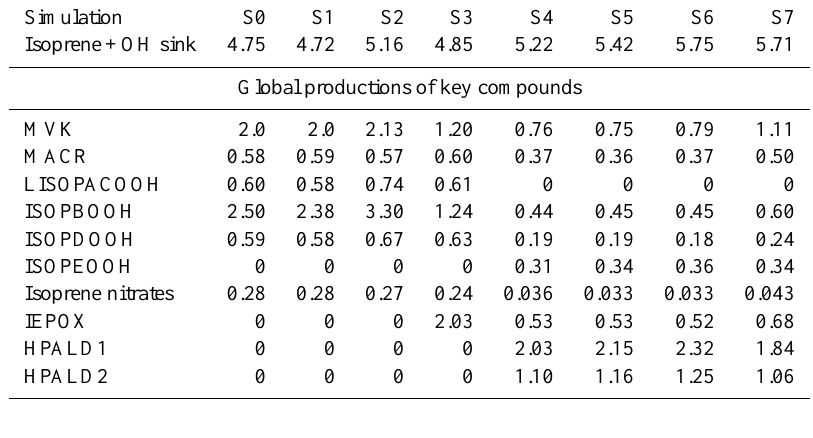
Table 3. Calculated annual isoprene+OH sink and global production of major by-products from the isoprene+OH reaction: MVK and MACR (not including their production from isoprene+O 3 ), hydroperoxides (LISOPACOOH, ISOPBOOH, ISOPDOOH, ISOPEOOH), iso- prene nitrates (LISOPACNO3, ISOPBNO3, and ISOPDNO3), epoxides (IEPOX), and hydroperoxy-aldehydes (HPALDs) for the simulations described in Table 2. Numbers are in Tmoleyr − 1 .